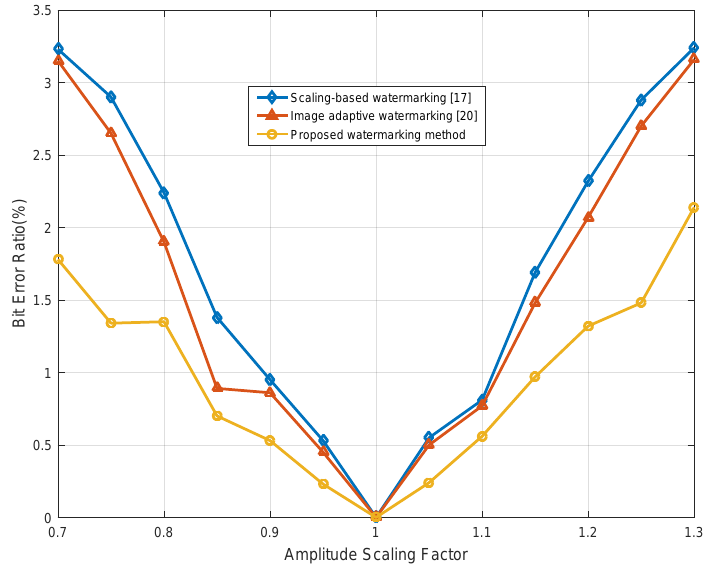
Figure 6. Performance comparison of various algorithms under scaling